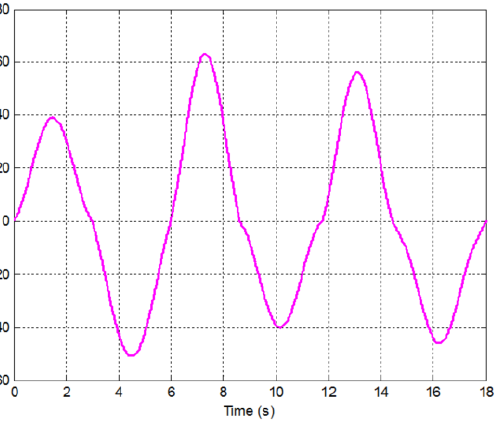
Fig. 4: Steering wheel angle input ( δ (cid:54) = 0) .